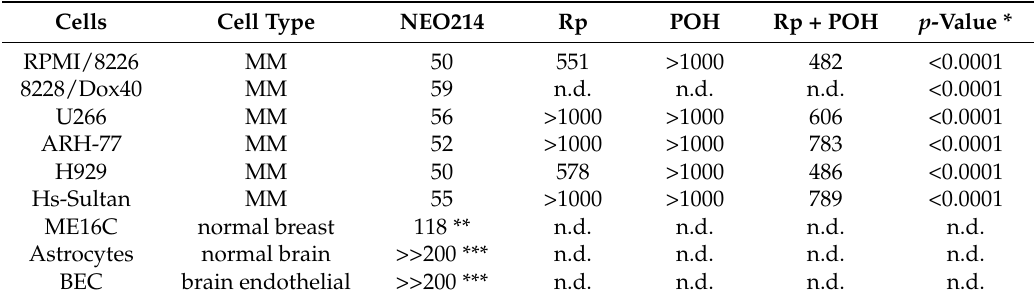
Table 1. Drug sensitivities of various human cell